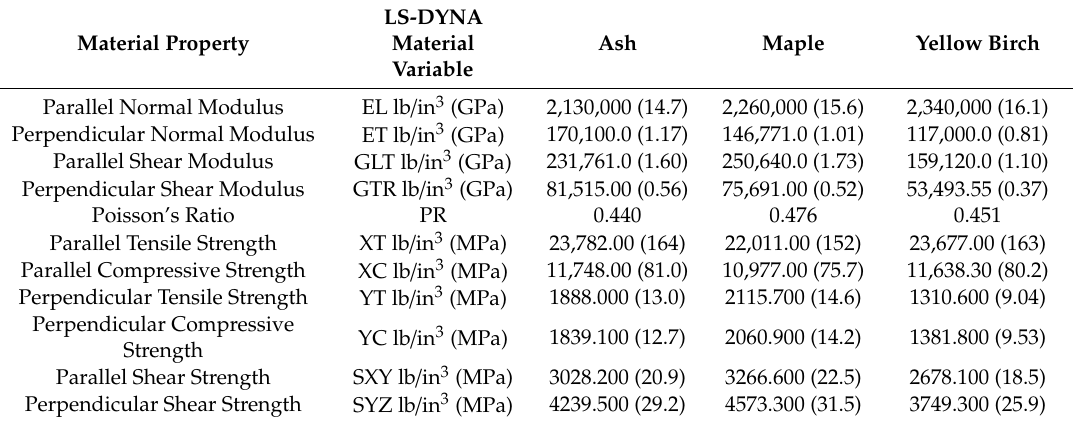
Table 1. Summary of wood species material properties.